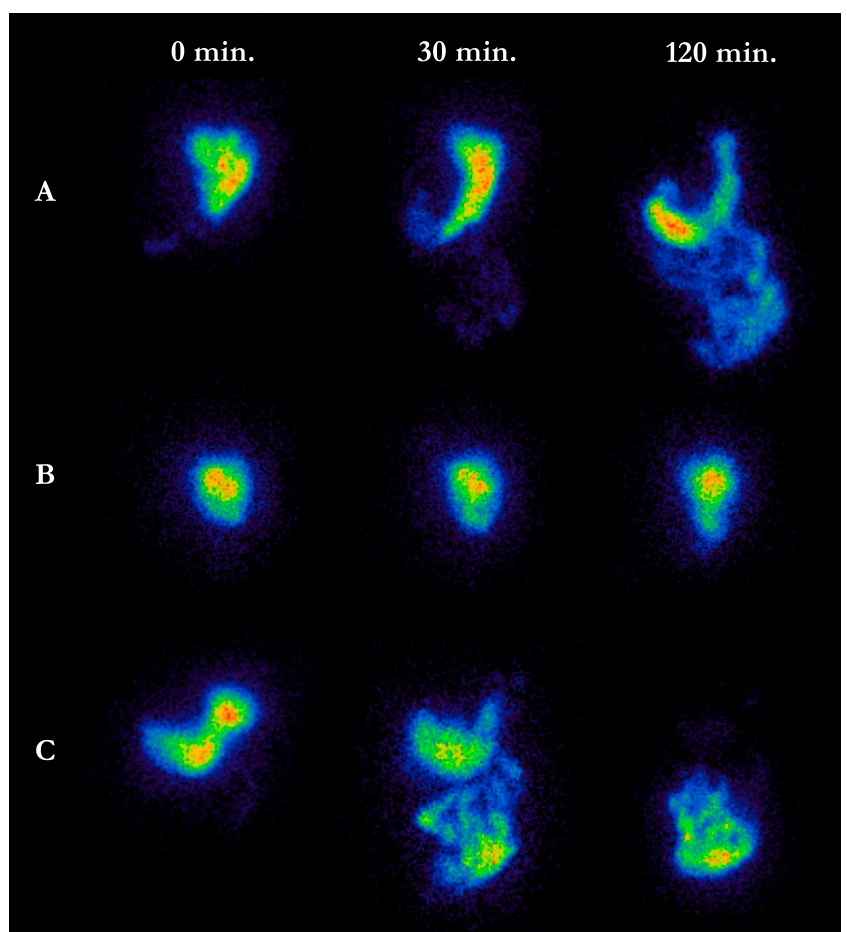
Figure 1. Gastric scintigraphy images at 0, 30 and 120 min after ingestion of a radioactive solid meal. ( A). Healthy control with normal gastric emptying time. ( B). Parkinson’s disease (PD) patient with severely delayed gastric emptying time compatible with gastroparesis. ( C). PD patient with rapid gastric emptying suggestive of ”gastric dumping” (compare the image taken at 30 min. to the image from A taken at 120 min.).